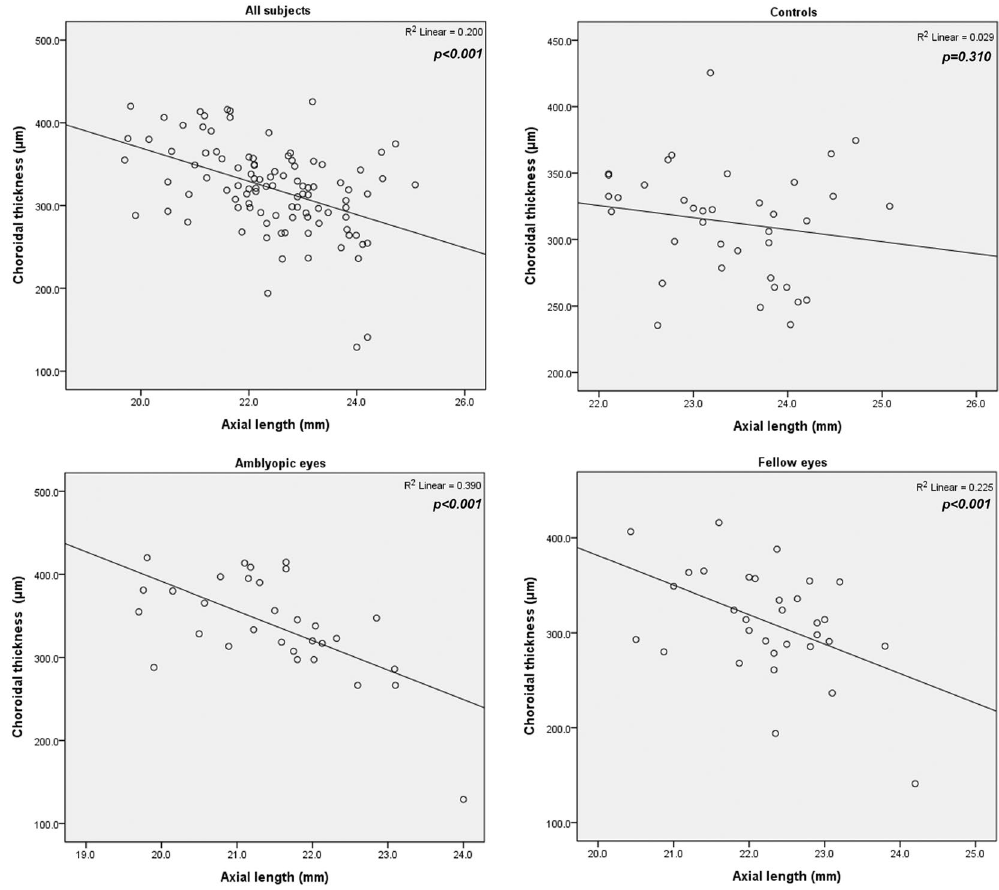
Figure 2. Correlation between axial length and subfoveal choroidal thickness. Subfoveal choroidal thickness had a negative correlation with axial length when all eyes were analyzed together ( P < 0.001) and in amblyopic eyes and fellow eyes (both P <